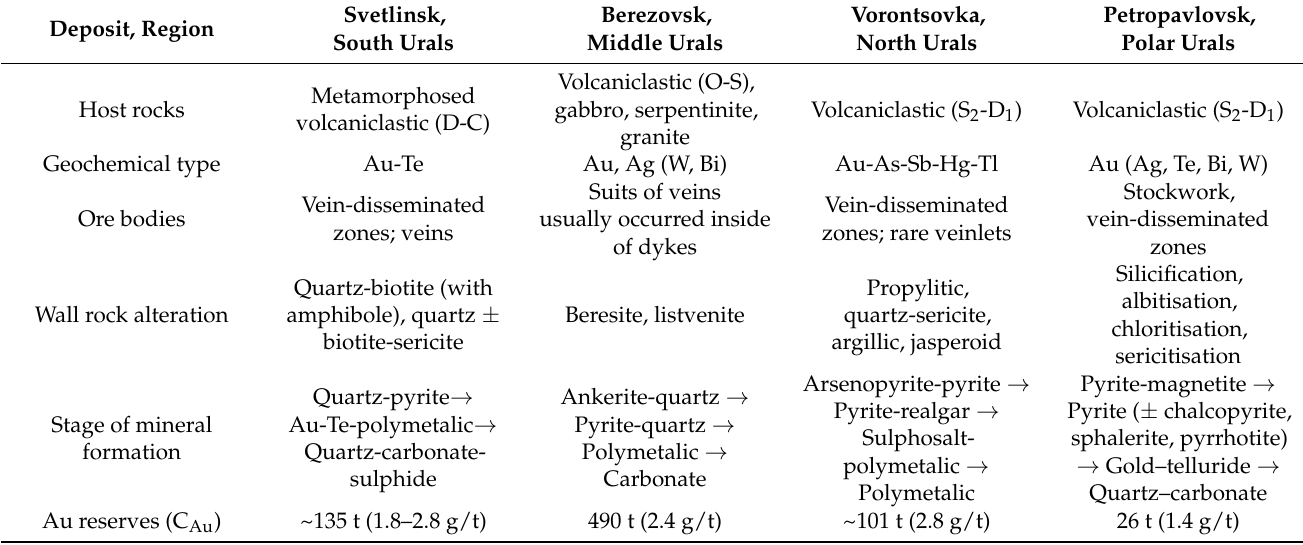
Table 2. Characteristics of studied gold deposits.